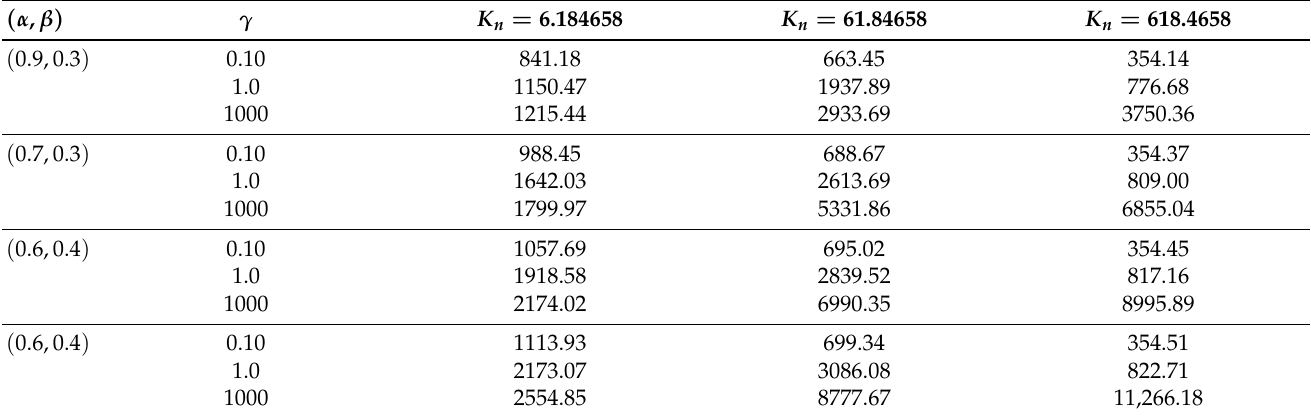
Table 11. ( T e ) max with different K n , γ , α and β ( α > β ) for Example